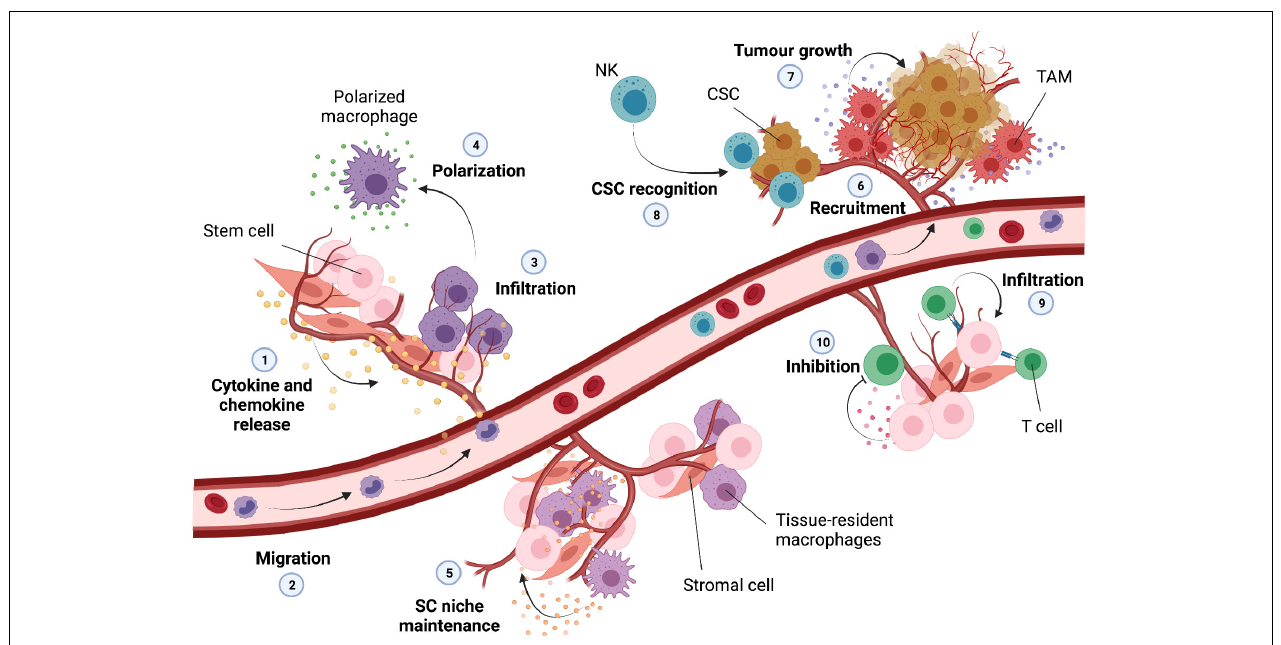
FIGURE 3 | Infiltration of immune cells into the normal stem cell and cancer stem cell niche. DNA damage can trigger the release of various cytokines and chemokines into the microenvironment (1); these can lead to migration and recruitment of macrophages (2) that exit the circulation and infiltrate into the tissue (3). The inflammatory microenvironment is then able to trigger the polarization of these macrophages (4) into M1 or M2 subtypes. Tissue-resident macrophages are normally present into the stem cell microenvironment, and they are important for the maintenance of the stem cell niche (5). The tumor microenvironment can lead to recruitment of various immune cells (6); tumor associated macrophages (TAM) can secrete inflammatory cytokines important for tumor growth and expansion (7); natural killer (NK) cells can potentially recognize and eliminate cancer stem cells (CSC) upon infiltration (8). T-cells can infiltrate into the normal stem cell niche (9) influencing stem cell proliferation and homeostasis; some types of stem cells are able to secrete molecules able to inhibit activation and differentiation of infiltrated T-cells (10).